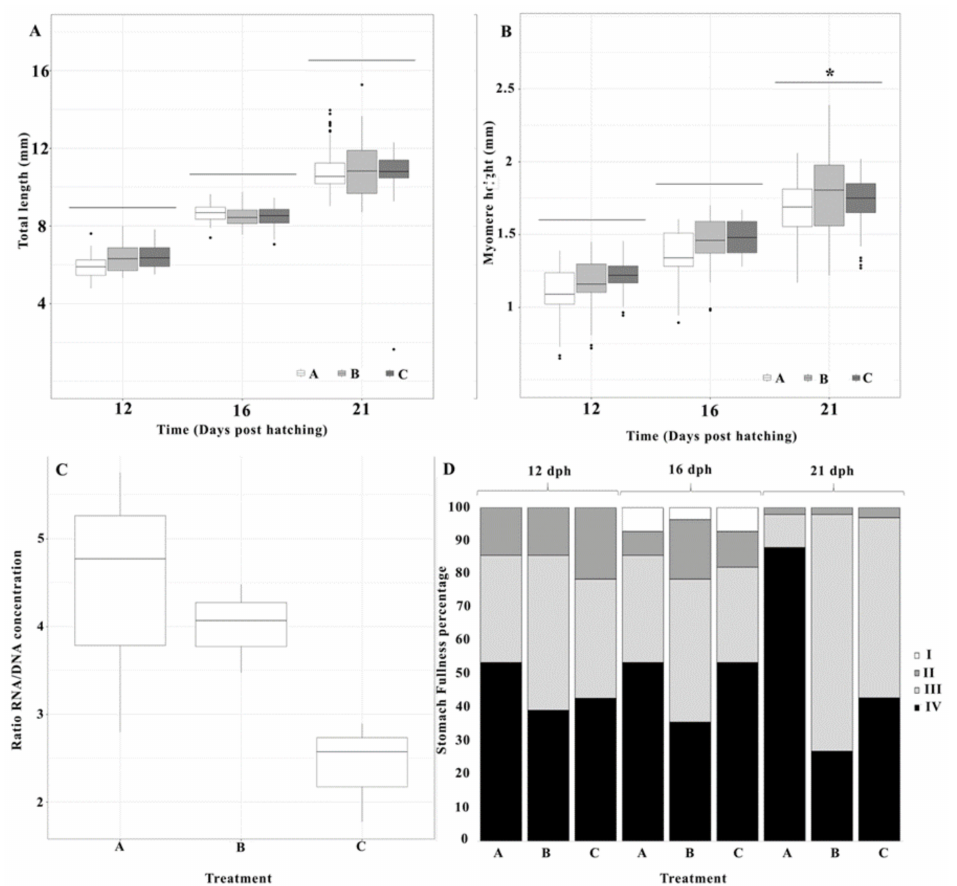
Figure 2. Larval growth parameters and stomach fullness from three diet treatments at days 12 (n = 40), 16 (n = 40) and 21 dph (n = 100). ( A ) Total length, ( B ) Myomere height, ( C ) RNA / DNA ratio (21 dph), ( D ) Stomach fullness expressed in percentage (1 to 4, with 4 being the maximum fullness, from darkest to lightest grey). Dots shown are the out layers, whiskers indicate the maximum and minimum values excluding out layers, the line in the middle of box is the median value and upper and lower quartiles are the ends of the box. Statistically significant di ff erences between treatments are marked with an